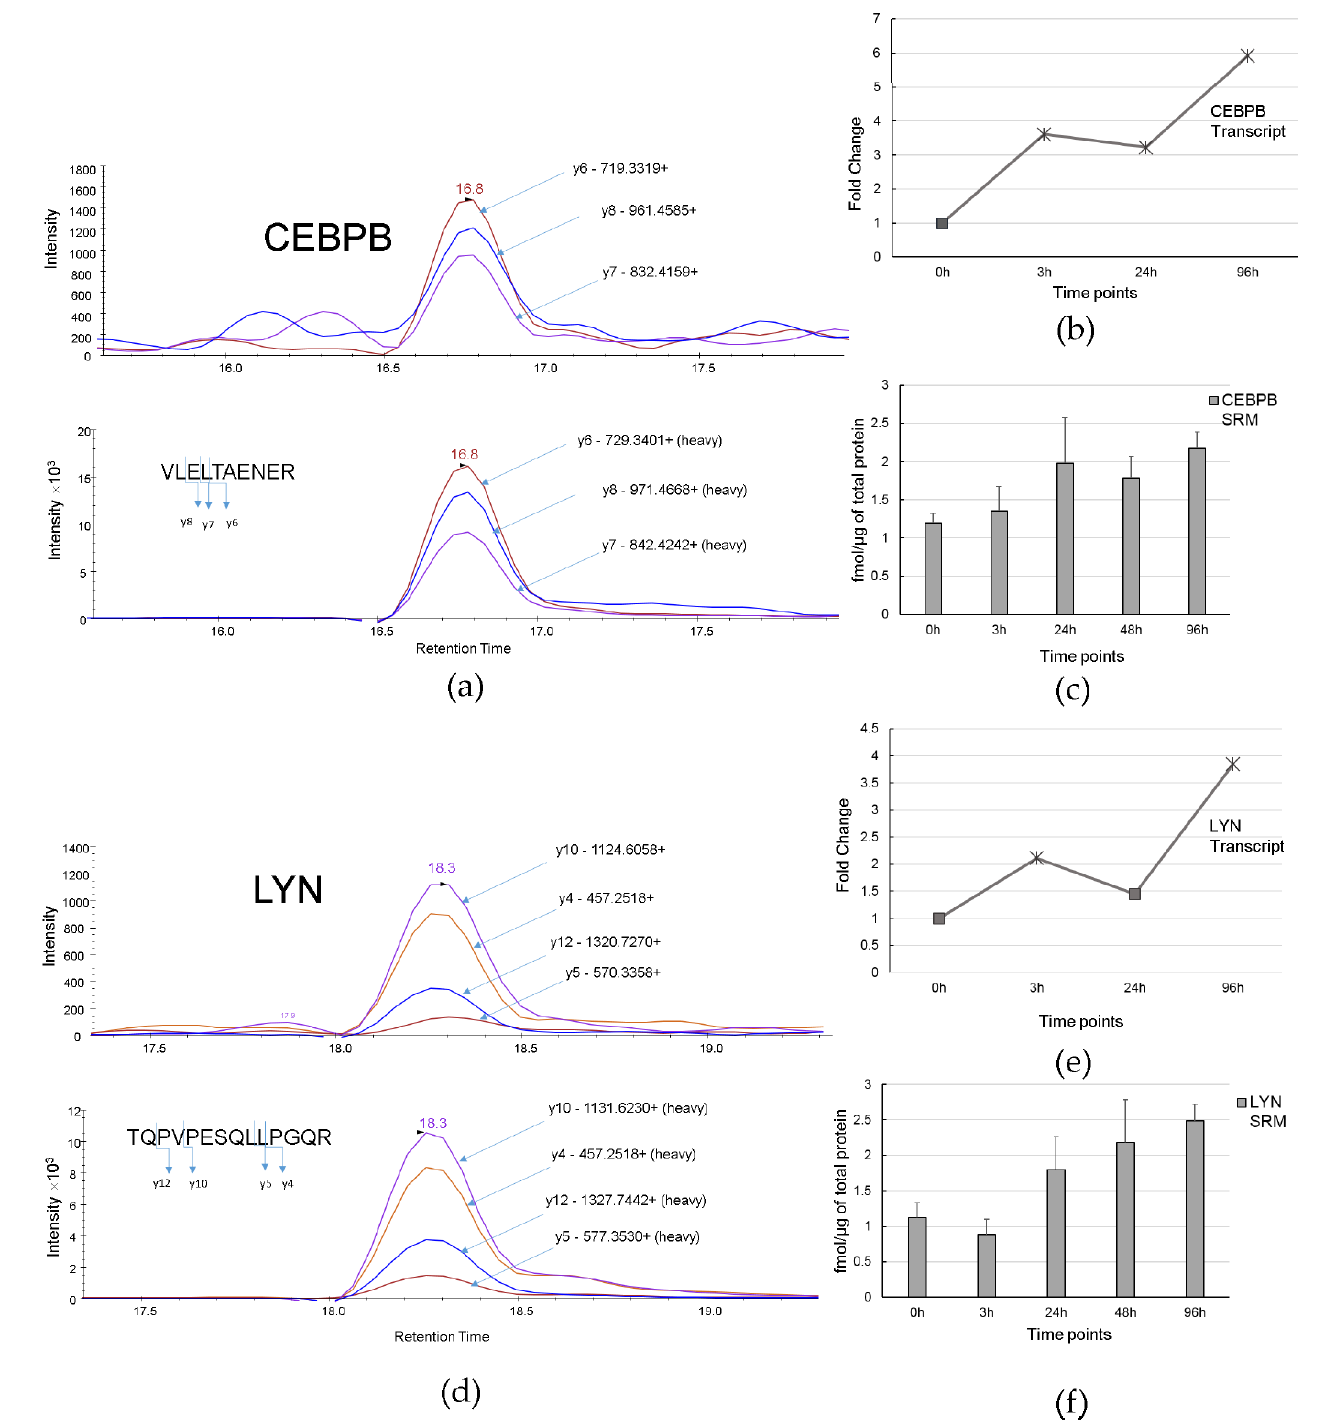
Figure 8. CEBPB and LYN expression during ATRA-induced granulocytic differentiation. ( a ) Trace of SRM transitions for native and stable isotope labeled peptide standard VLELTAENER of CEBPB. ( b ) Profile of CEBPB transcript expression during HL60 differentiation (fold change ≥ 2, p -value ≤ 0.05 at 3 h, 24 h, and 96 h) ( c ) Protein expression level of CEBPB obtained by SRM (three biological replicates) at 3 h, 24 h, 48 h, 96 h. ( d ) Trace of SRM transitions for native and standard isotopically-labeled peptide TQPVPESQLLPGQR of LYN. ( e ) Profile of transcript expression LYN during HL60 differentiation (fold change ≥ 2, p -value ≤ 0.05 at 3 h and 96 h). ( f ) Protein expression level of LYN obtained by SRM (three biological replicates) at 3 h, 24 h, 48 h, 96 h.